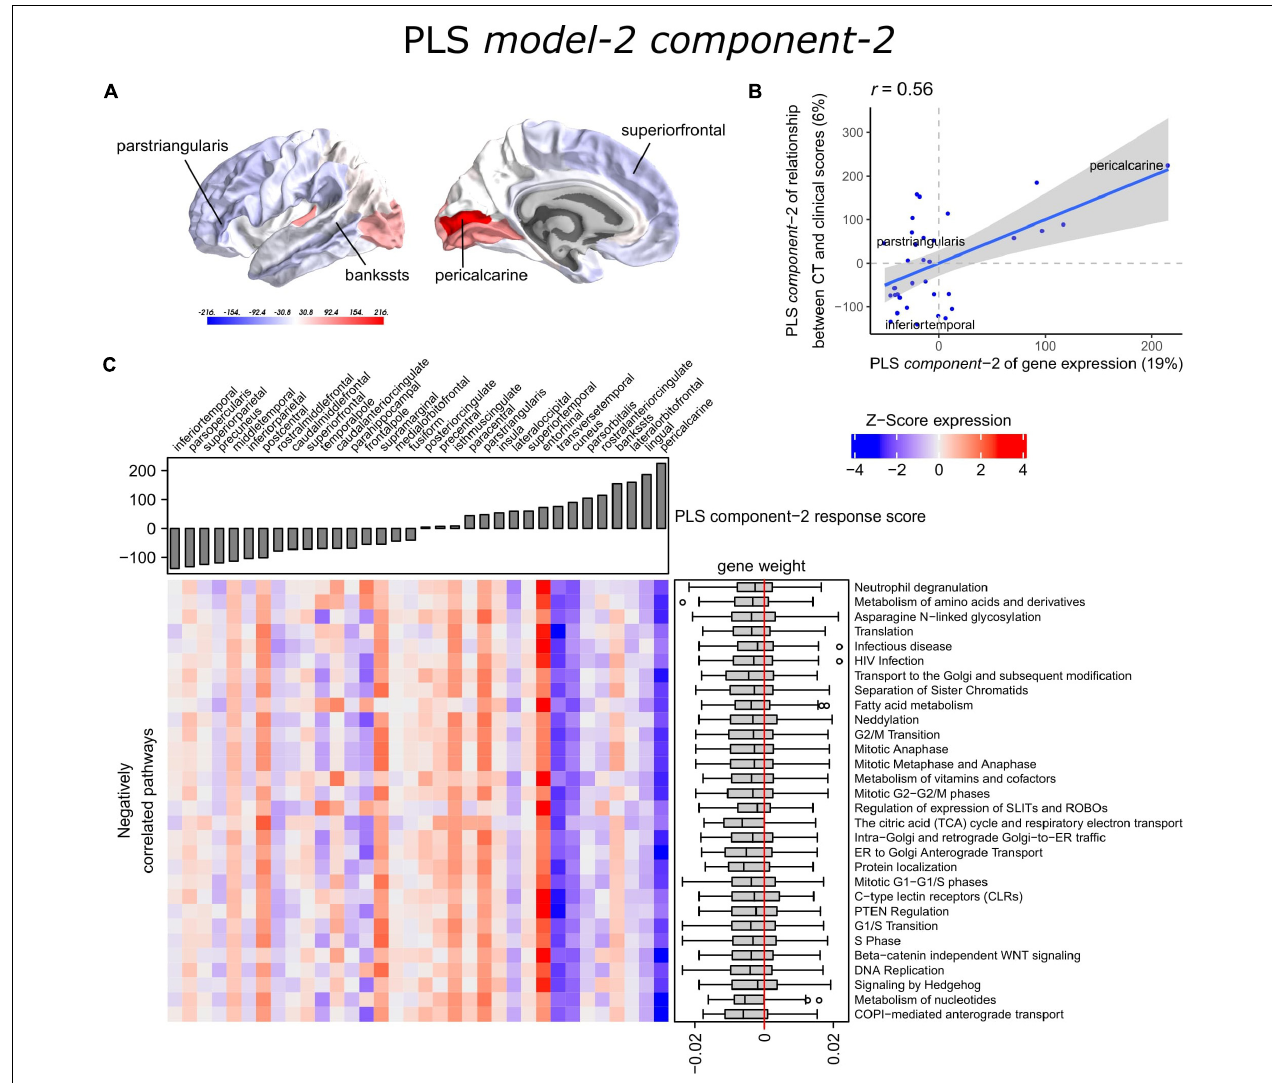
FIGURE 6 | Transcriptional signatures of PLS component-2 in PLS model-2 predictive of the relationship between cortical thickness (CT) and clinical scores. (A) PLS scores for PLS component-2 of the predictor variables (gene expression) and (B) its correlation with PLS component-1 of the response variables ( t -statistic of β 1 in Eq. 1). Axes show the percentage of explained variance for each component; r indicates the Pearson correlation. (C) Mean expression across cortical regions (columns) of genes in the top 30 significant pathways (rows). A complete heatmap with all significant pathways is given in Supplementary Figure 9